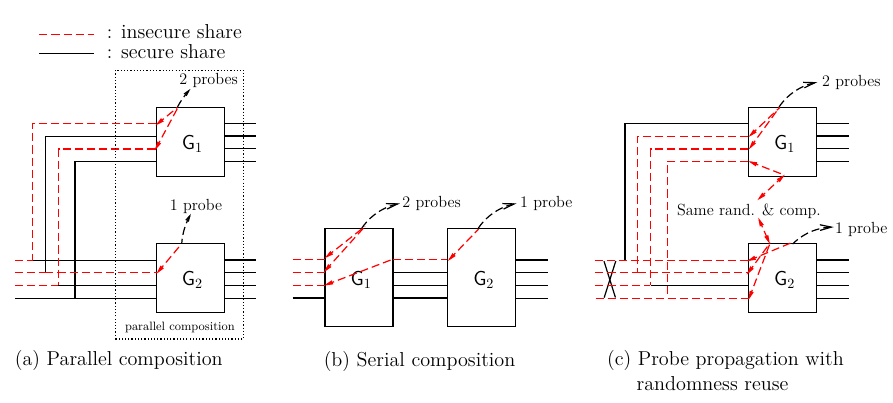
Figure 5: Examples of probe